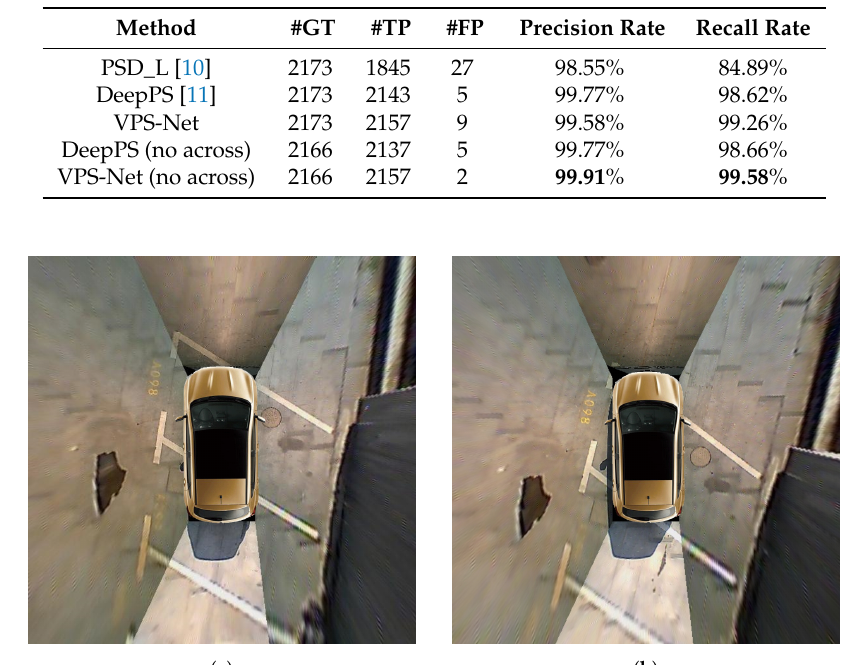
Table 4. Parking slot detection performance of different methods in the ps2.0 test set.